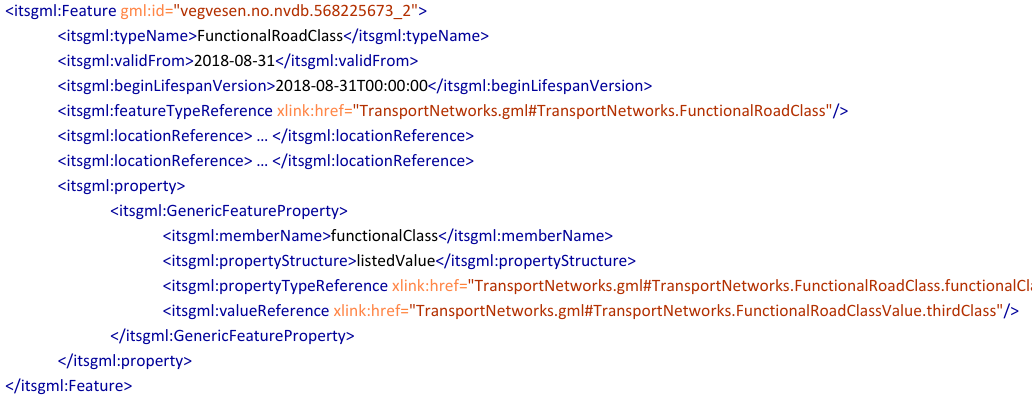
Figure 10. Extract of the INSPIRE TN Feature Catalogue Exchange GML file.